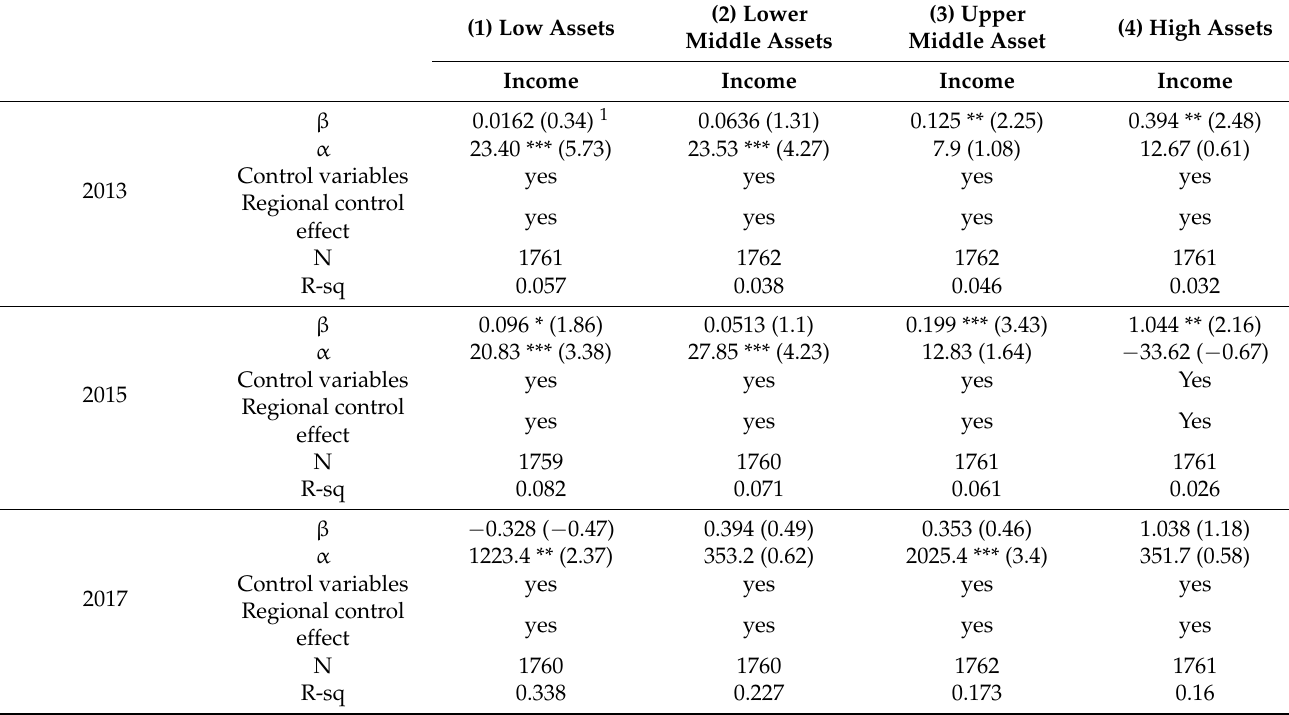
Table 10. Regression results of family asset